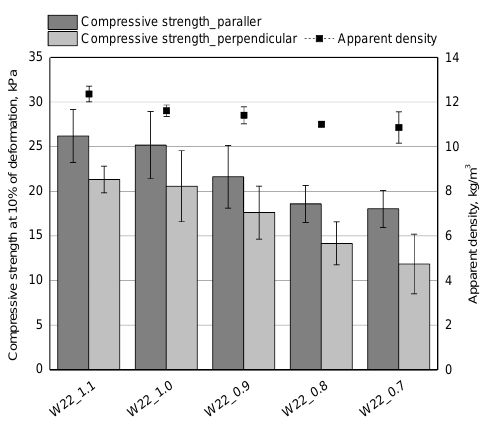
Figure 10. The apparent density and compressive strength of the open-cell PUR foams with different NCO indices.